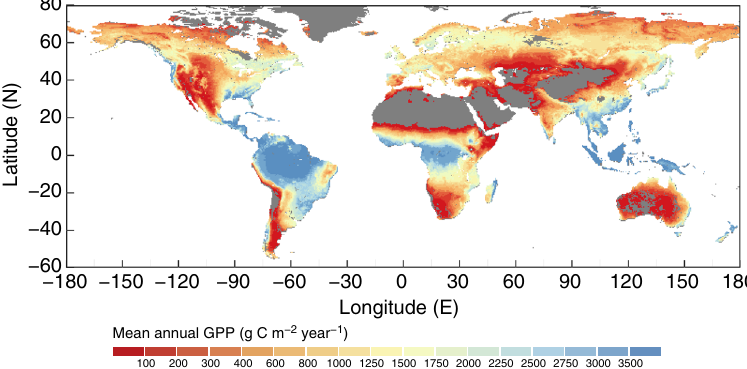
Fig. 1 Validation of the ecosystem water use ef fi ciency (WUE) model and spatial variability of estimated mean annual WUE and gross primary production (GPP) over the period of 1982 – 2011. a Validation of annual WUE in g C mm − 1 H 2 O using observations from 51 eddy covariance fl ux sites ( n = 229 site- years). The red line is the 1:1 line and blue line is fi tted using least square regression. b Validation of the trends in annual WUE in mg C mm − 1 H 2 O per year at 11 eddy covariance fl ux sites with at least 7 years observations. The red line is the 1:1 line. The error bars indicate one standard deviation of estimated and observed trends using different methods. The inset shows the mean of observed and estimated trends of all the 11 stations. c , d Estimated spatial details (0.5° × 0.5°) of the global mean annual ecosystem WUE in g C mm − 1 H 2 O and gross primary production (GPP) in g C m − 2 per year, respectively, with bare land coloured in